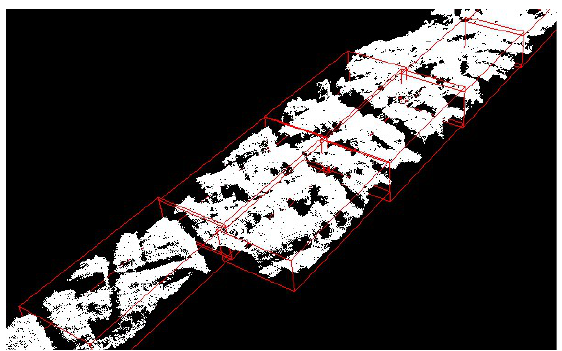
Figure 11: Segmenting part of the cloud in sub-clouds